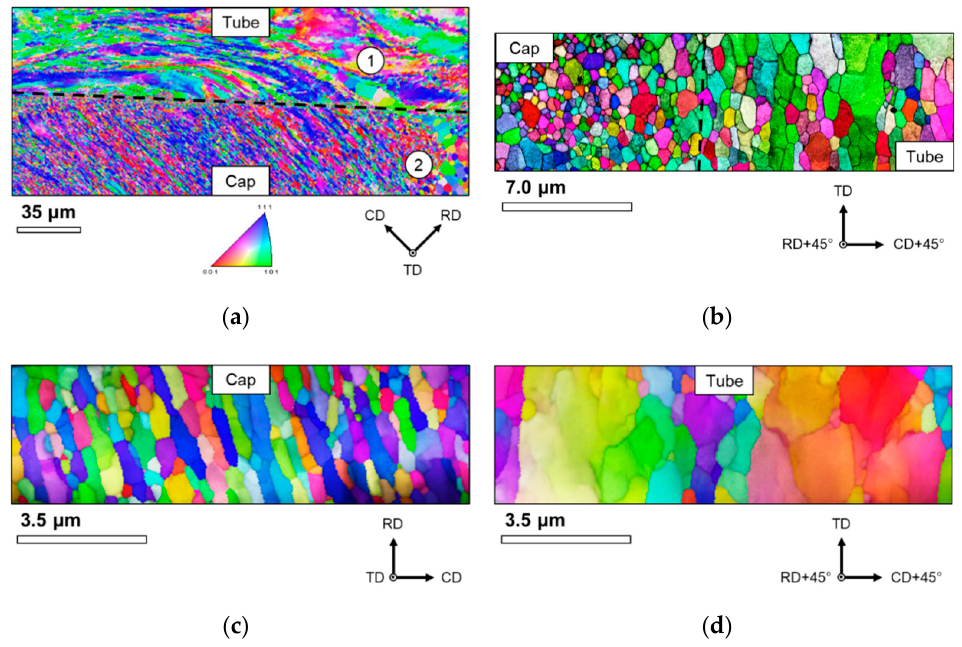
Figure 3. ( a ) EBSD grain orientation map (relative to TD) showing the lack of significant grain recrystallization or coarsening at the weld line. Highlight 1 marks a cluster of recrystallized grains along the weld line, whereas highlight 2 indicates another example of enlarged cap grains caused by the heterogeneity of hot extrusion. ( b – d ) TKD grain orientation maps showing material across the weld line, in the cap near the weld (~10 μ m away), and in the tube near the weld, respectively. Here, all maps were collected from joints produced using Weld Condition 1 and colored according to the crystal orientation parallel to the indicated viewing direction for each map. Note the difference in sample orientation (i.e., frame of reference) between ( b , c ) and the accompanying change in appearance for the cap grains.